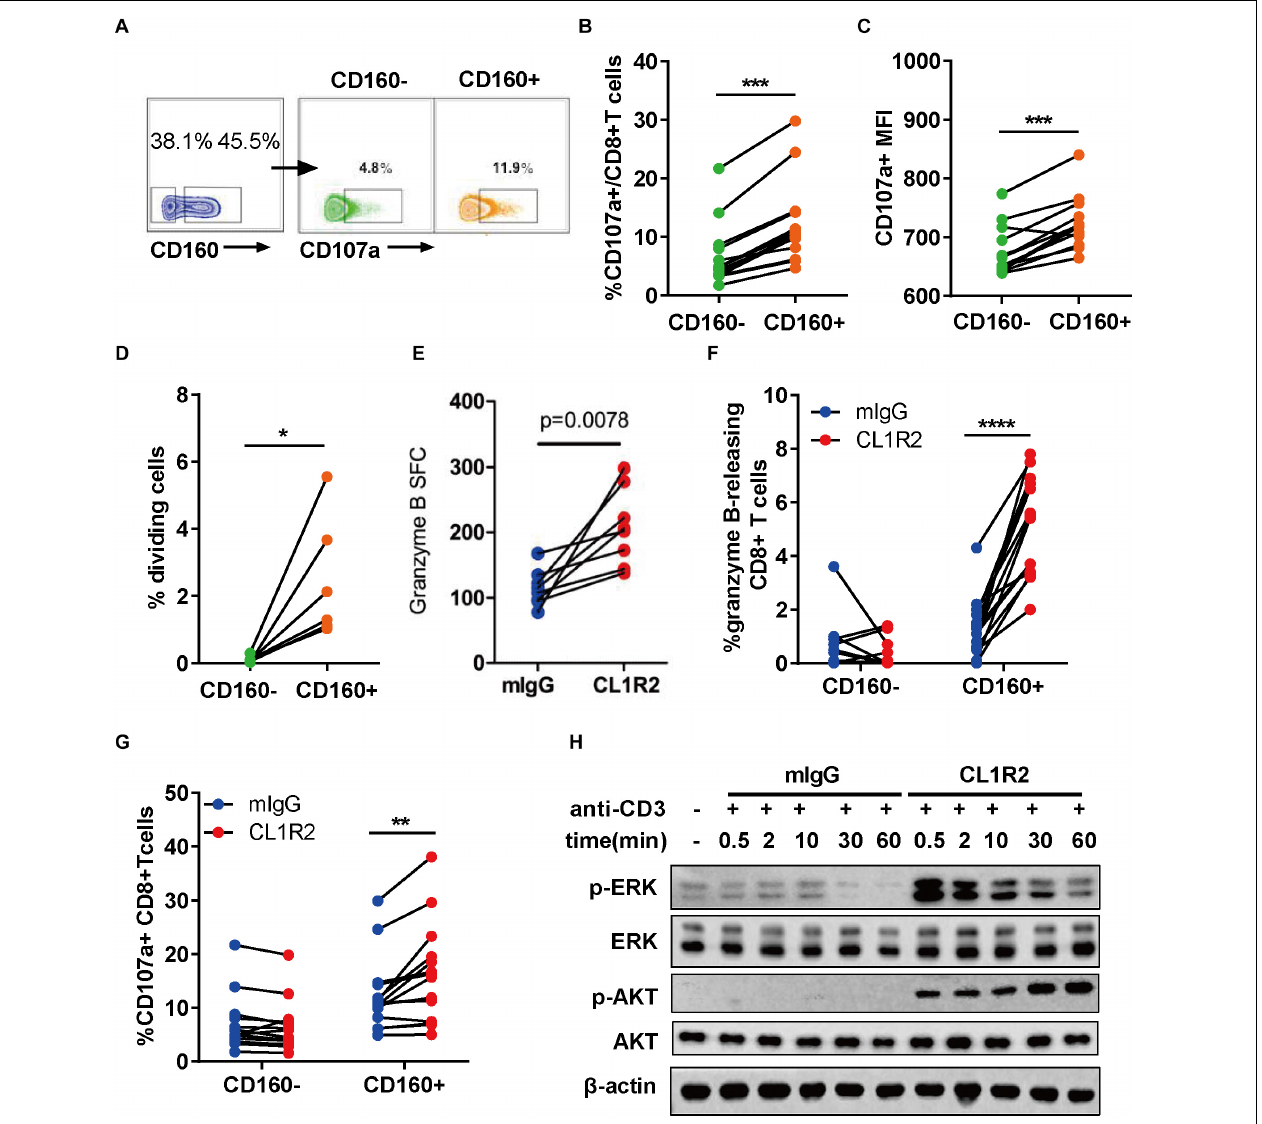
FIGURE 2 | CD160 defines a functional and proliferative CD8+ T cell subset in response to HIV Gag stimulation. (A) Representative flow cytometric plots of gating strategy for the functional analyses of CD160– and CD160+ CD8+ T cells derived from patients with chronic HIV infection after HIV-1 Gag peptide stimulation. (B,C) Comparison of CD107a-expressing cell percentage (B) and mean fluorescence intensity of CD107a (C) between paired CD160– and CD160+ CD8+ T cells after HIV-1 Gag peptide stimulation, n = 14. (D) Assessment of HIV-1 Gag peptide-stimulated cell proliferation CD8+ T cells between CD160+ and CD160– T cells. The purified CD8+ T cells were labeled with efluor670 dye (5 uM) and then stimulated with HIV-1 Gag peptides for 7 days. Changes in the percentage of proliferating cells between paired CD160– and CD160+ CD8+ T are shown in (D) ( n = 6). (E) Compiled data of ELISPOT assay determining the frequency of granzyme B-releasing cells within the total CD8+ T cells induced by HIV-1 Gag peptide stimulation in the presence of mIgG or CL1R2 antibody. Frequency is expressed as the number of cells per 10 6 of total CD8+ T cells. n = 15. (F,G) Compiled data of flow cytometric analysis of the percentage change in granzyme B-releasing cells (F) and CD107a-positive cells (G) within the total CD8+ T cells induced by CL1R2 antibody relative to mIgG treatment, when both coupled with HIV Gag peptide stimulation. n = 15. (H) Immunoblotting analyses of time course of activation of AKT and ERK in human peripheral blood mononuclear cell-derived CD8+ T cells responding to the co-treatment of anti-CD3 antibody and CL1R2 antibody or mIgG. The abundance of phosphorylated AKT and ERK is normalized to that of β -actin and expressed as fold change relative to the values obtained with the samples exposed to anti-CD3 plus mIgG for 0.5 min. The data in (B–G) are analyzed by paired t test, with the p values indicated in the figure. * P < 0.05; ** P < 0.01; *** P < 0.001; **** P < 0.0001.